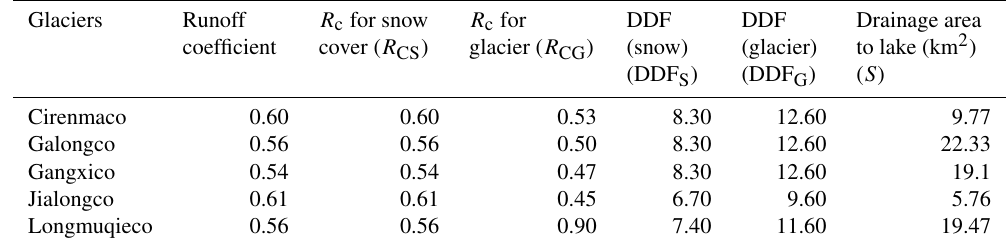
Table 10. Parameters for the water balance calculation of glacial lakes.